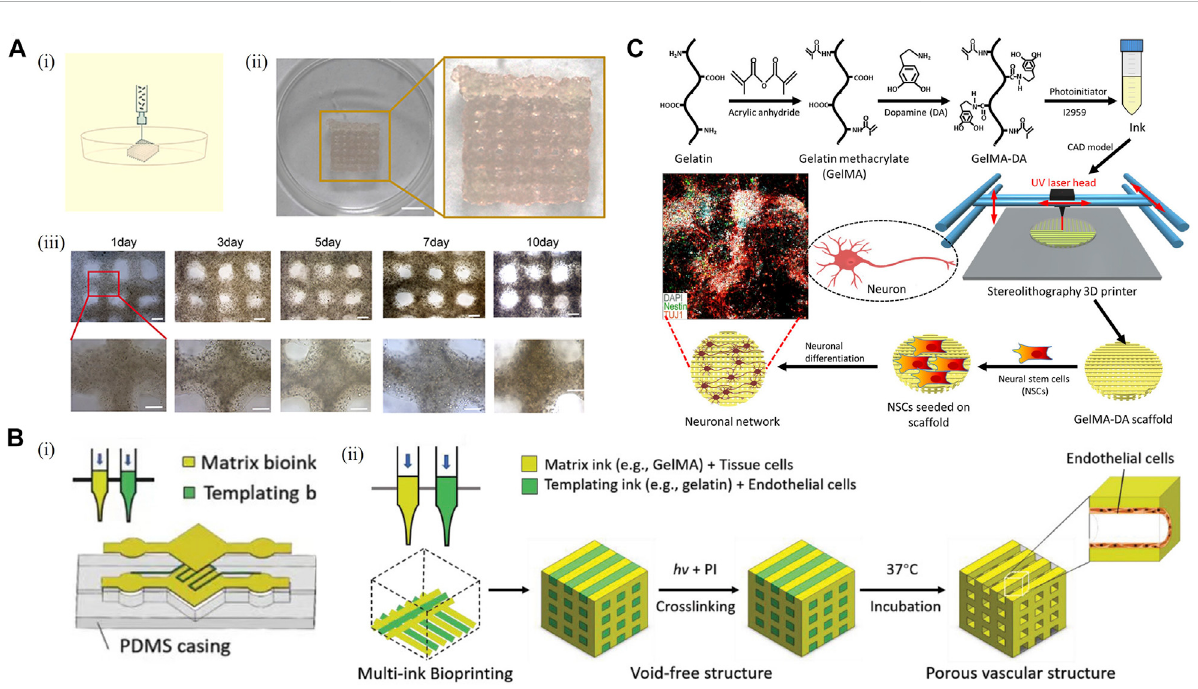
FIGURE 3 3D bioprinting model. (A) Establishment of a 3D bioprinted model. [(A), i] Schematic representation of the 3D bioprinting procedure. [(A), ii] Image of a 3D bioprinted model. Scale bar: 50 mm. [(A), iii] View of the in vitro model on days 1, 3, 5, 7, and 10 after 3D bioprinting. Scale bar: 1 mm. (Sun et al., 2020) (B) 3D bioprinted model for endothelialization and micro fl uidic perfusion using bioinks and sacri fi cial materials. [(B), i] Schematic illustrationof a hydrogel-based micro fl uidic system generated with a sacri fi cial bioink used to template prede fi ned channels. [(B), ii] Schematic illustration of the modi fi ed 3D bioprinting process, where a templating bioink loaded with endothelial cells for endothelialization and a matrix bioink are bioprinted side byside, followed by crosslinking ofthematrixbioinkand 37 ° C incubation to release thesacri fi cial bioink (Ouyangetal.,2020). (C) Schematic illustration of a 3D bioprinted model using dopamine-modi fi ed bioink. Adapted with permission. (Zhou et al., 2018) Copyright © 2018, American Chemical